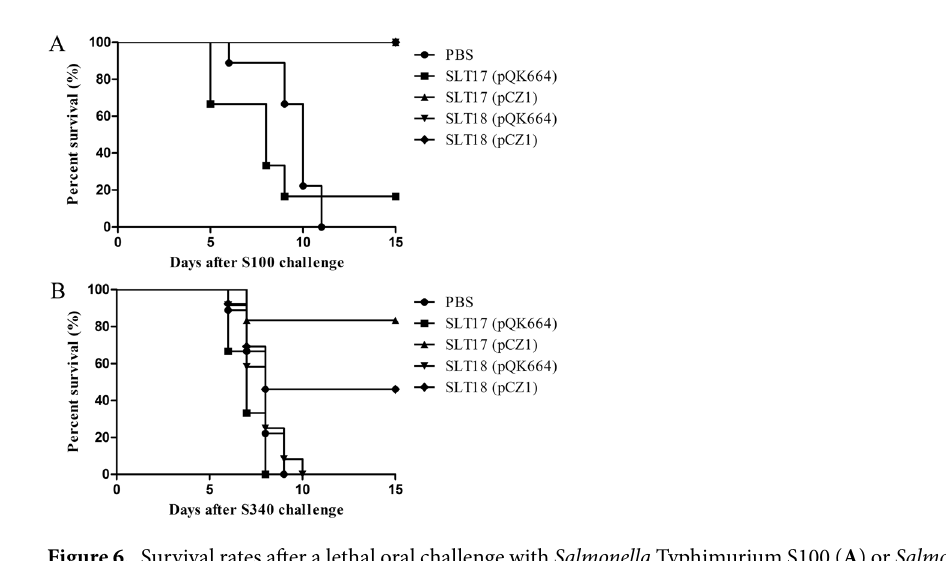
Figure 6. Survival rates after a lethal oral challenge with Salmonella Typhimurium S100 ( A ) or Salmonella Choleraesuis S340 ( B ) are shown. The immunized mice (n = 12/group) were challenged with at least 100 × LD 50 of virulent S100 or virulent S340. Mortality was recorded daily for 15